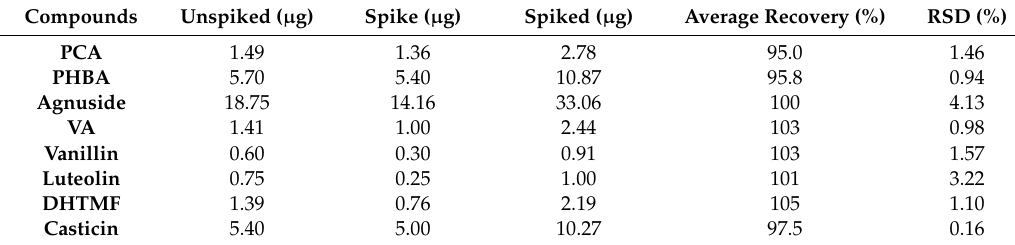
Table 3. The results of recovery test ( n =